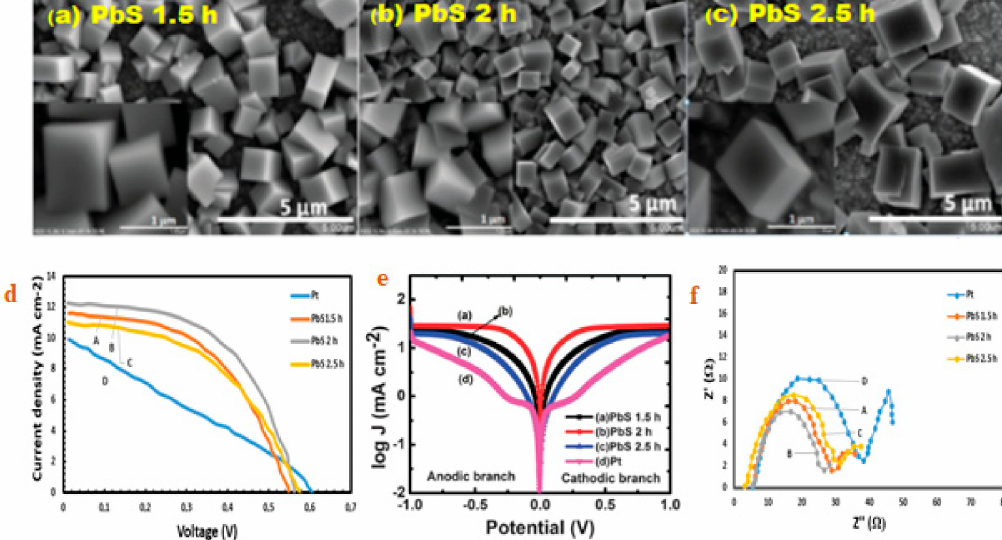
Figure 8. ( a – c ) PbS CEs SEM images, ( d ) J–V, ( e ) Tafel and ( f ) Nyquist plots (reproduced from ref. [111] with permission from the American Chemical